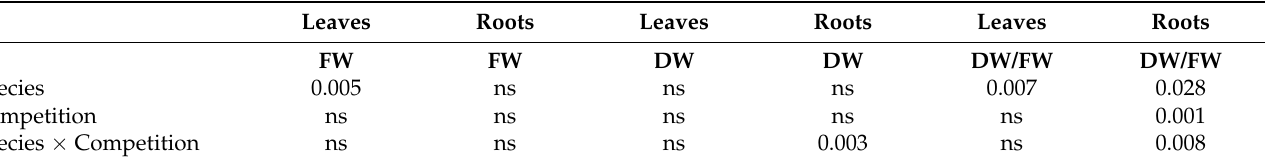
Table 2. ANOVA significance for the effect of species (soybean and C. album ), competition (single-species tanks or mixed- species tanks) and their interaction on the percentage of salt-treated samples over nontreated samples. ( A ) Fresh weight (FW), dry weight (DW) and DW/FW ratio of leaves and roots. ( B ) Content of N and soluble proteins in leaves. ( C ) Na+ and K+ content in leaves and roots, Na and K translocation factor (Na leaves/Na roots, K leaves/K roots). ( D ) Phenolic compounds in leaves and roots and antioxidant capacity via FRAP in leaves and roots. ( E ) Antioxidant enzyme activity (guaiacol peroxidase (GPX), ascorbate peroxidase (APX), catalase (CAT) and lipid peroxidation via malondialdehyde (MDA) assay in leaves. ( F ) Proline content in leaves and roots. ns = not